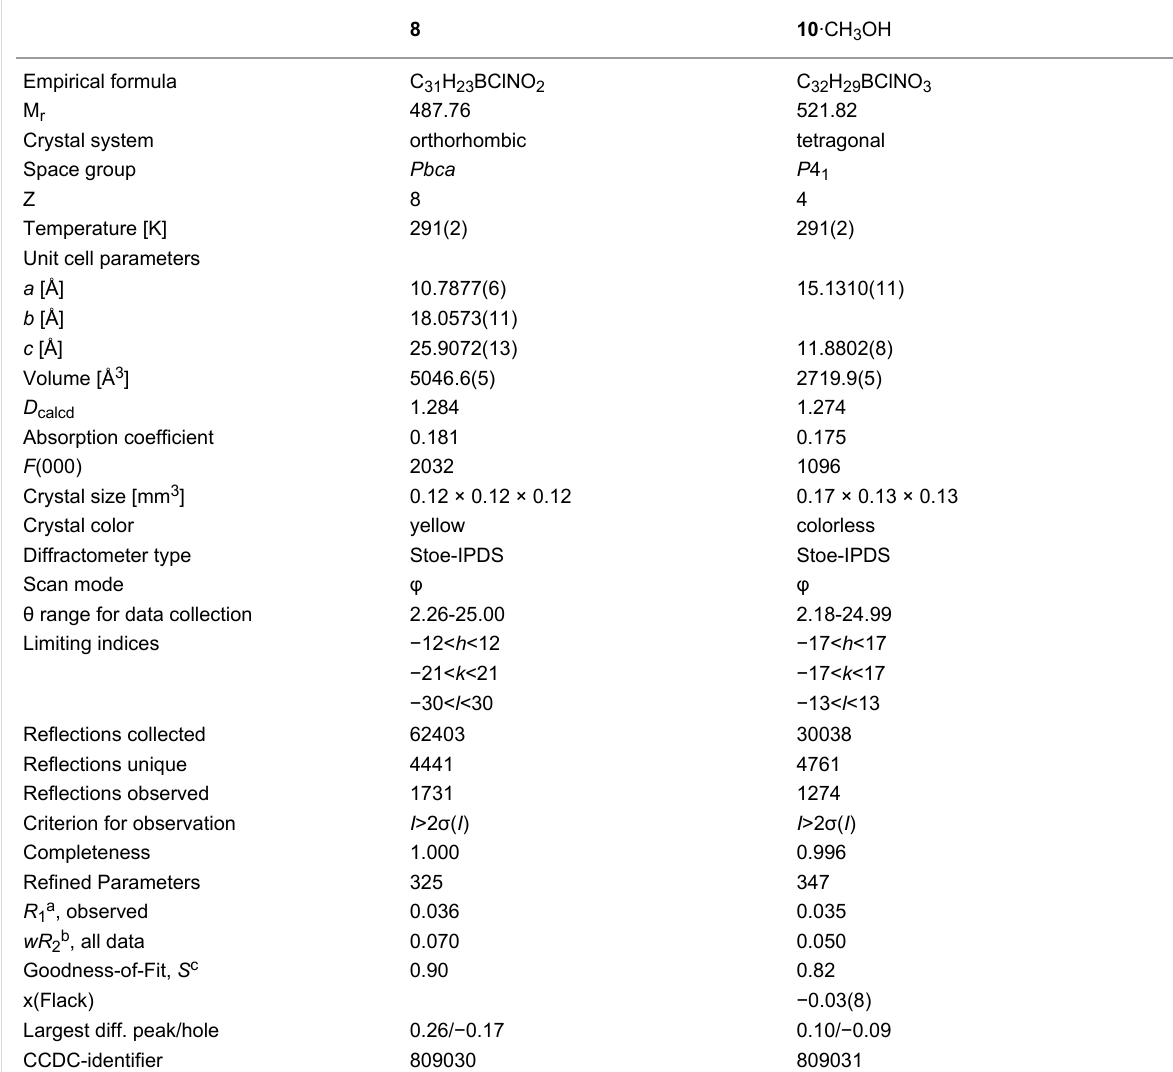
Table 3: Summary of crystal data, details of intensity measurements and structure refinements of 8 and 10 ·CH 3